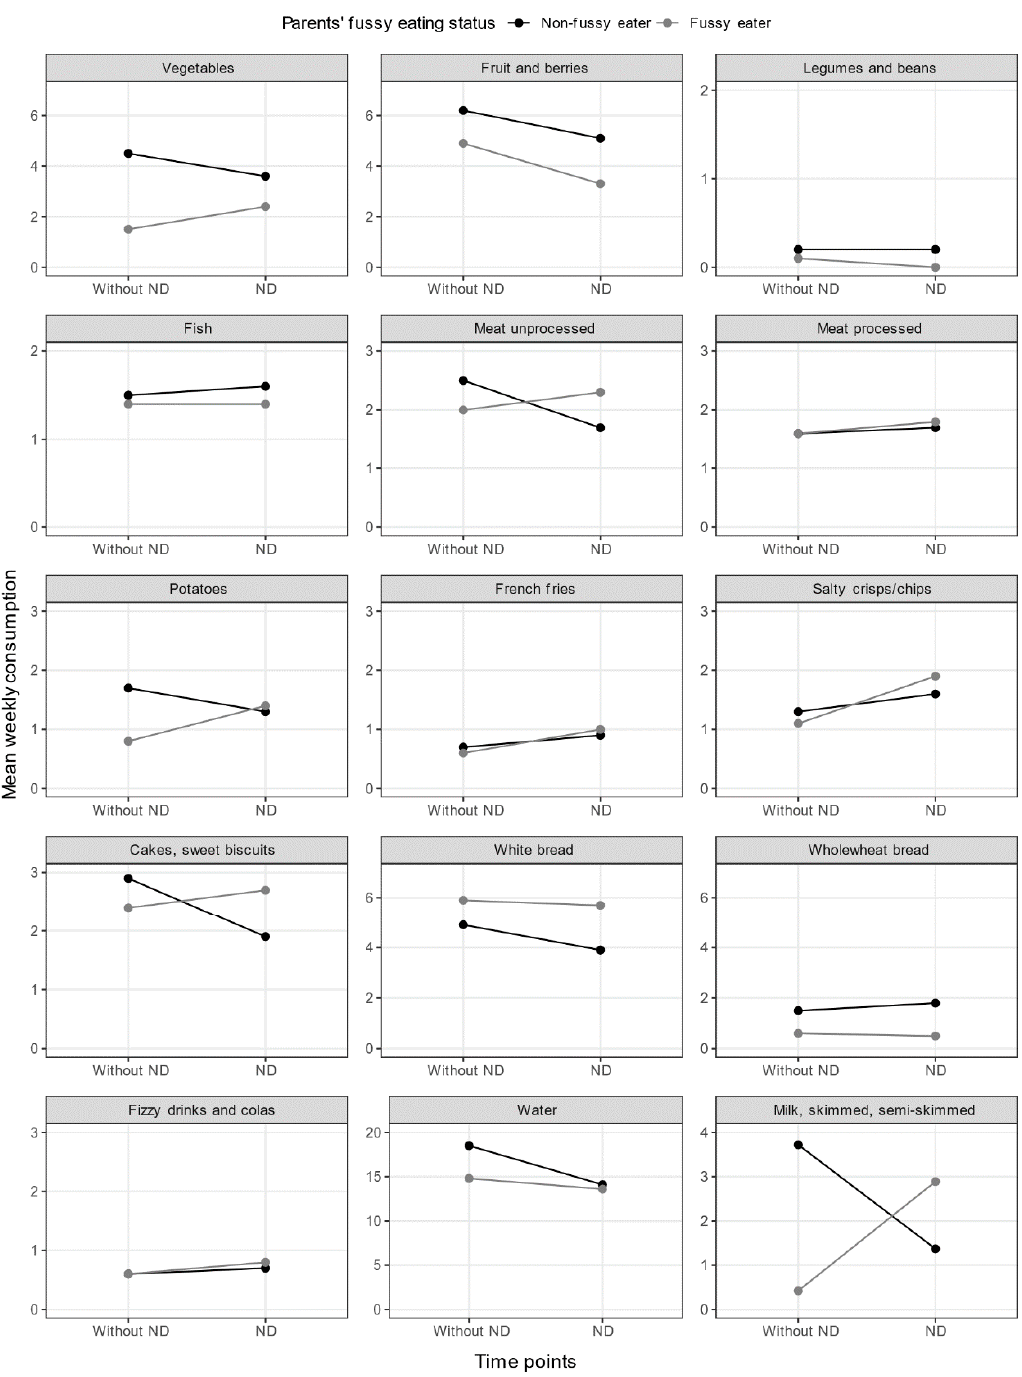
Figure 2. Children’s weekly mean food consumption (frequency) for various food items, based on children’s ND-status, and parents’ fussy eating status.